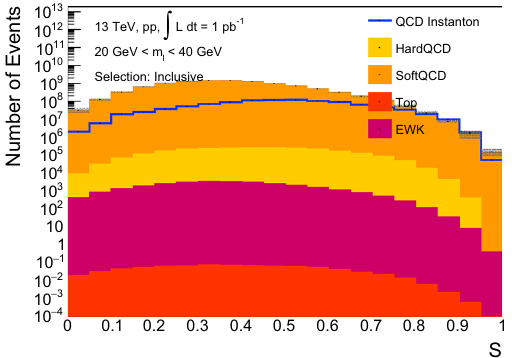
Fig. 8 Predicted distributions of the event sphericity, S (left), and pseudo rapidity, η , of reconstructed charged particles (right) for vari- ous processes, normalised to the expected event yields for an integrated (cid:8) luminosity of L = 1pb − 1 . The invariant mass of all reconstructed